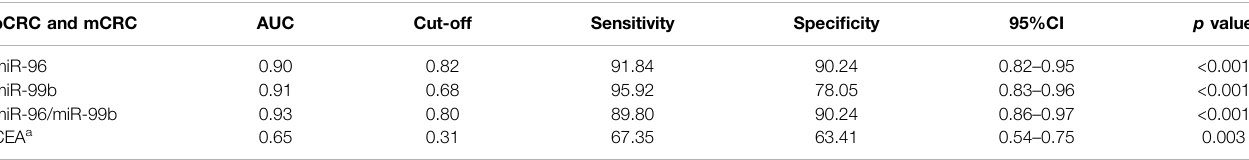
TABLE 5 | The diagnostic value of miRNAs between different groups of